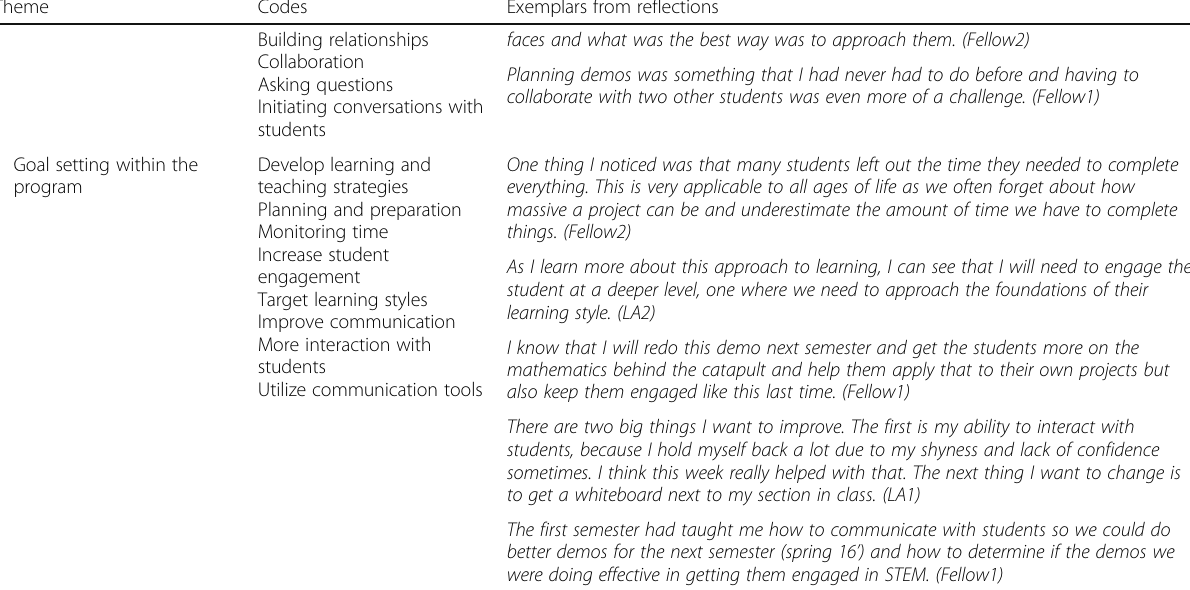
Table 4 Themes, codes, and exemplars